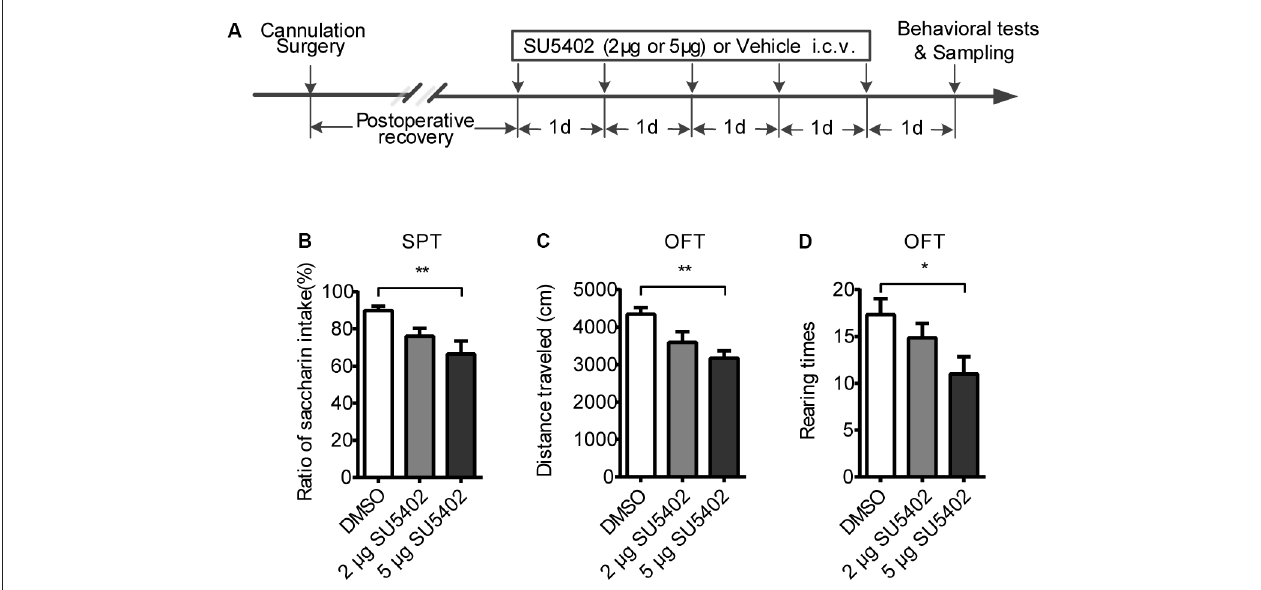
FIGURE 4 | The behavioral effects of FGFR inhibitor (SU5402). (A) The timeline of Experiment 2. Two groups respectively received 2 µ g or 5 µ g doses of central SU5402 infusions for five consecutive days. Dimethyl sulfoxide (DMSO) was used as Vehicle in control group. (B) Saccharin preference test. A 5 µ g dose of SU5402 infusions induced significant decreased ratio of saccharin intake. (C,D) OFT. A 5 µ g dose of SU5402 infusions decreased the distance traveled and rearing times. One-way ANOVA with Dunnett’s multiple comparisons test, n = 6 per group. Data are presented as the means ± SEM. ∗ p < 0.05, ∗∗ p < 0.01. i.c.v., intracerebroventricular; SPT, Saccharin preference test; OFT, Open field